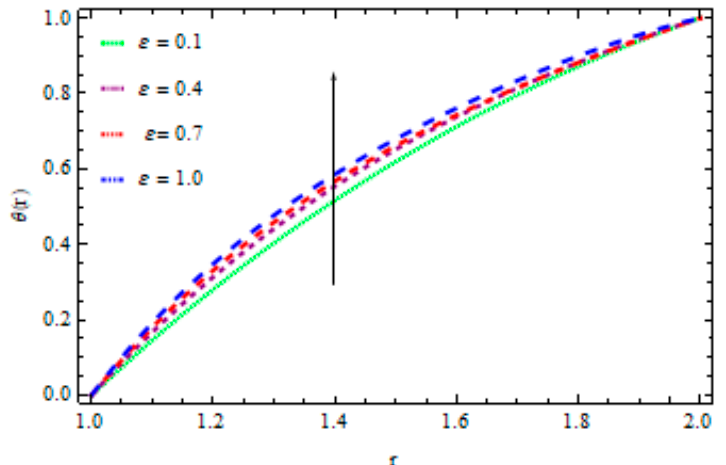
Figure 11. The influence of ε on temperature distribution for Reynolds’ model when